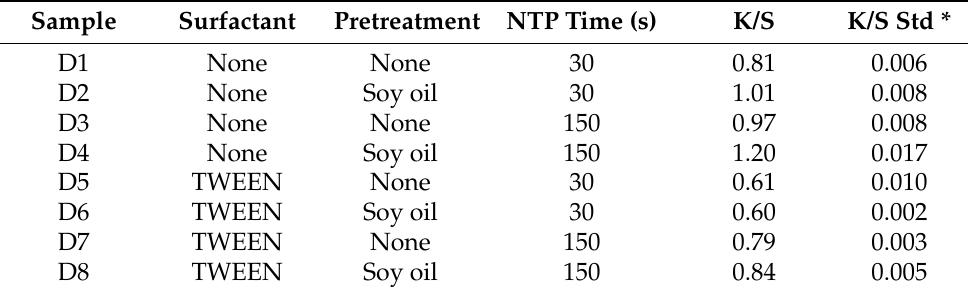
Table 4. Experiment D: experimental design and the results @